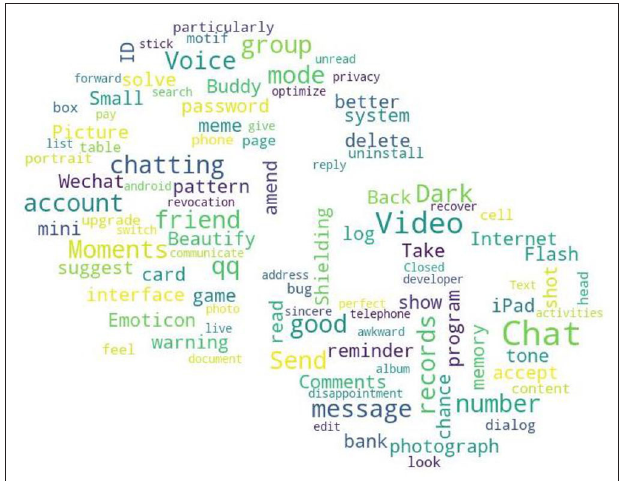
FIGURE 2 | Functions deficiency on WeChat.